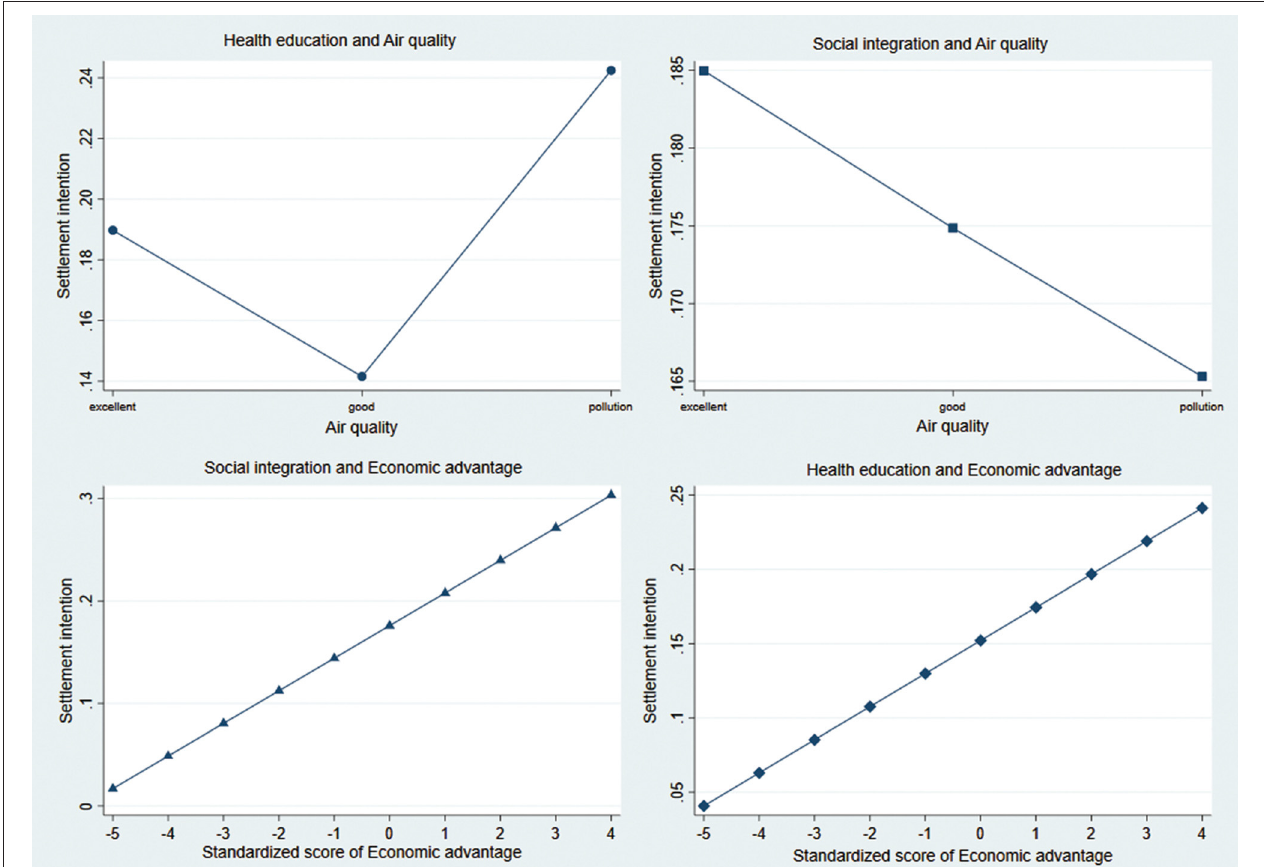
FIGURE 2 | The interactive effects of health education, social organizational participation, air quality, and economic advantages on settlement intention of migrants.